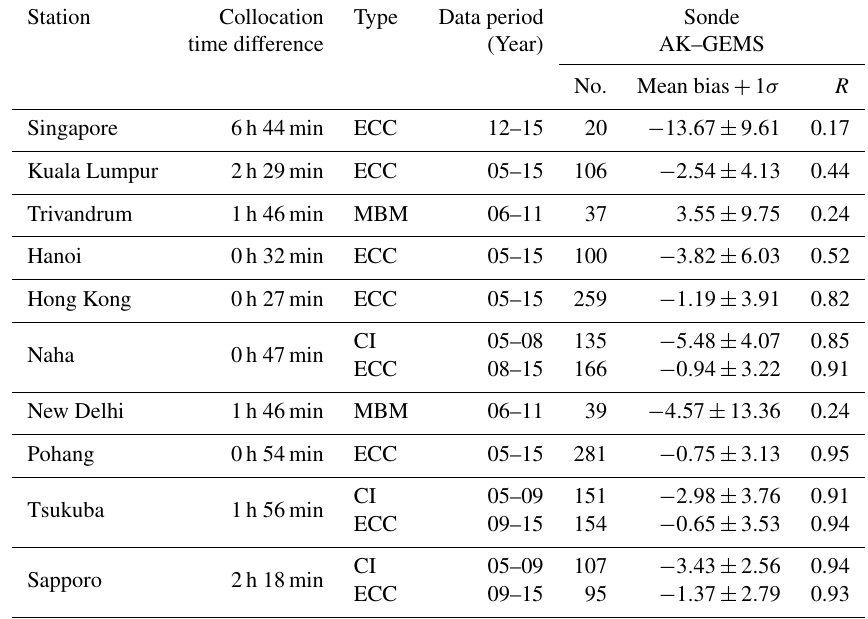
Table 2. Comparison statistics (mean bias in DU, 1 σ standard deviation in DU, and R , correlation coefficient) between GEMS-simulated tropospheric ozone column and ozonesonde measurements convolved with GEMS averaging kernels.